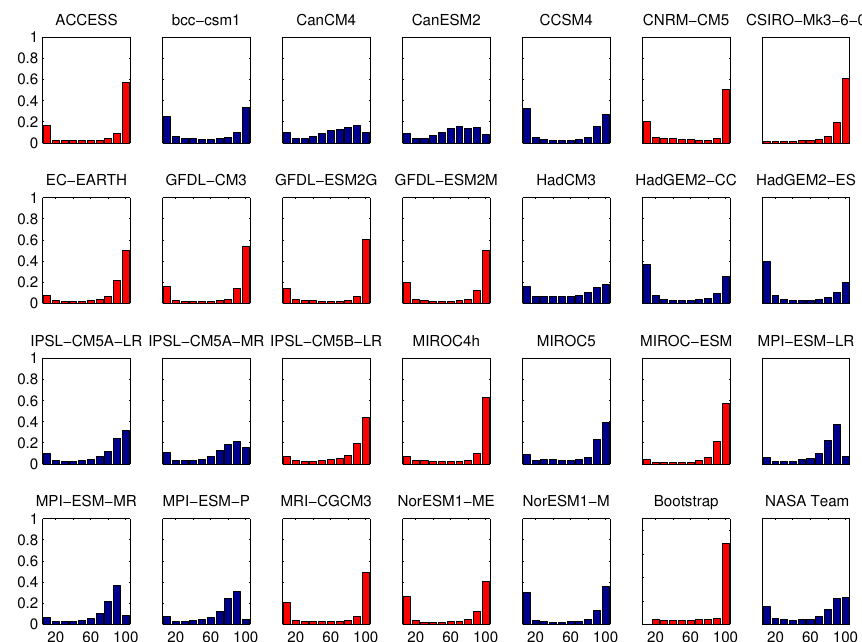
Fig. 4. Histogram of 1979–2005 September sea-ice concentration in all grid cells with at least 0.1% sea-ice concentration in CMIP5 model simulations. The numbers on the x axis denote the upper limit of each bar: e.g. 20 denotes the concentration range 10 to 20%. Red panels denote histograms with a compact sea-ice cover, while blue panels denote histograms with a loose sea-ice cover. For models with multiple simulations, the ensemble mean is